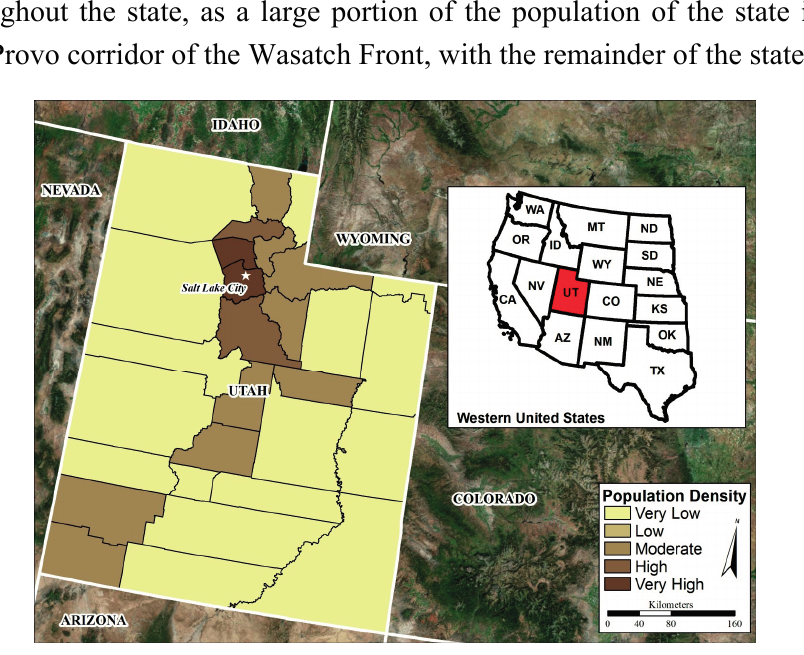
Figure 1. The state of Utah in the Western United States with county population by land area